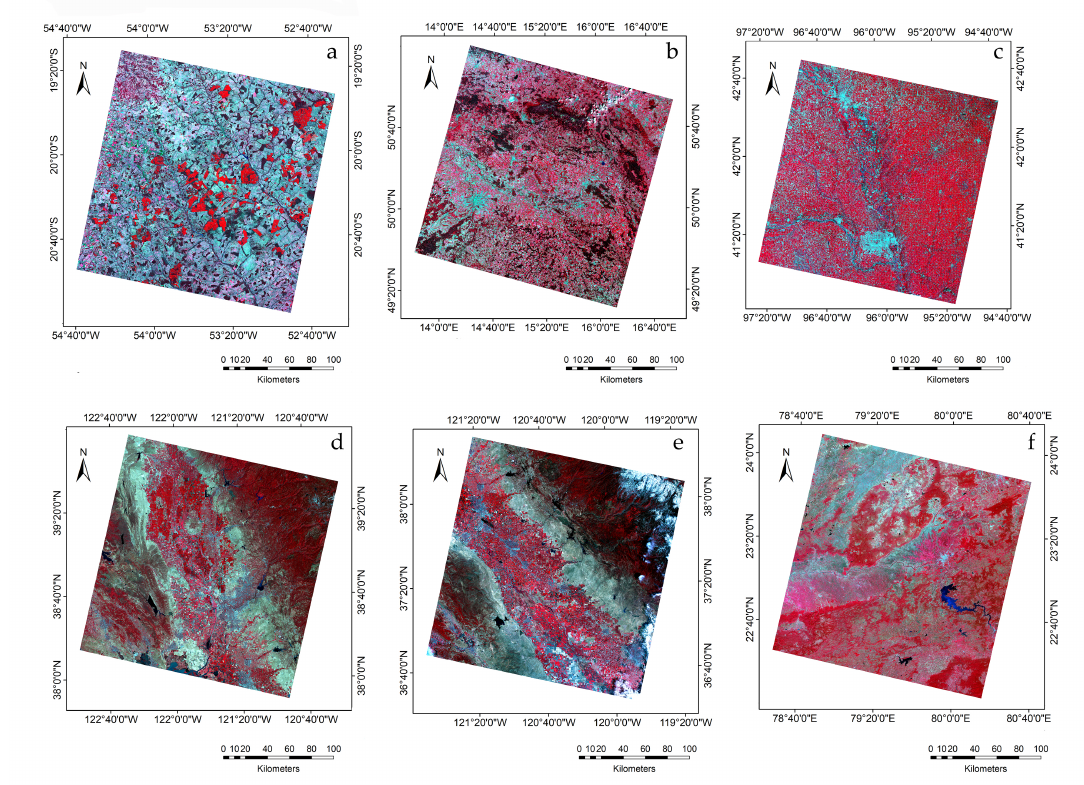
Figure 2. Landsat 8 OLI color-infrared images at 30-m spatial resolution for: ( a ) Site 1, image acquired on 13 July 2017. ( b ) Site 2, image acquired on 20 June 2017. ( c ) Site 3, image acquired on 16 July 2017. ( d ) Site 4, image acquired on 16 July 2017. ( e ) Site 5, image acquired on 9 July 2017, and ( f ) Site 6 image acquired on 17 October 2017. The outlines in Panels b and e delineate the analyzed